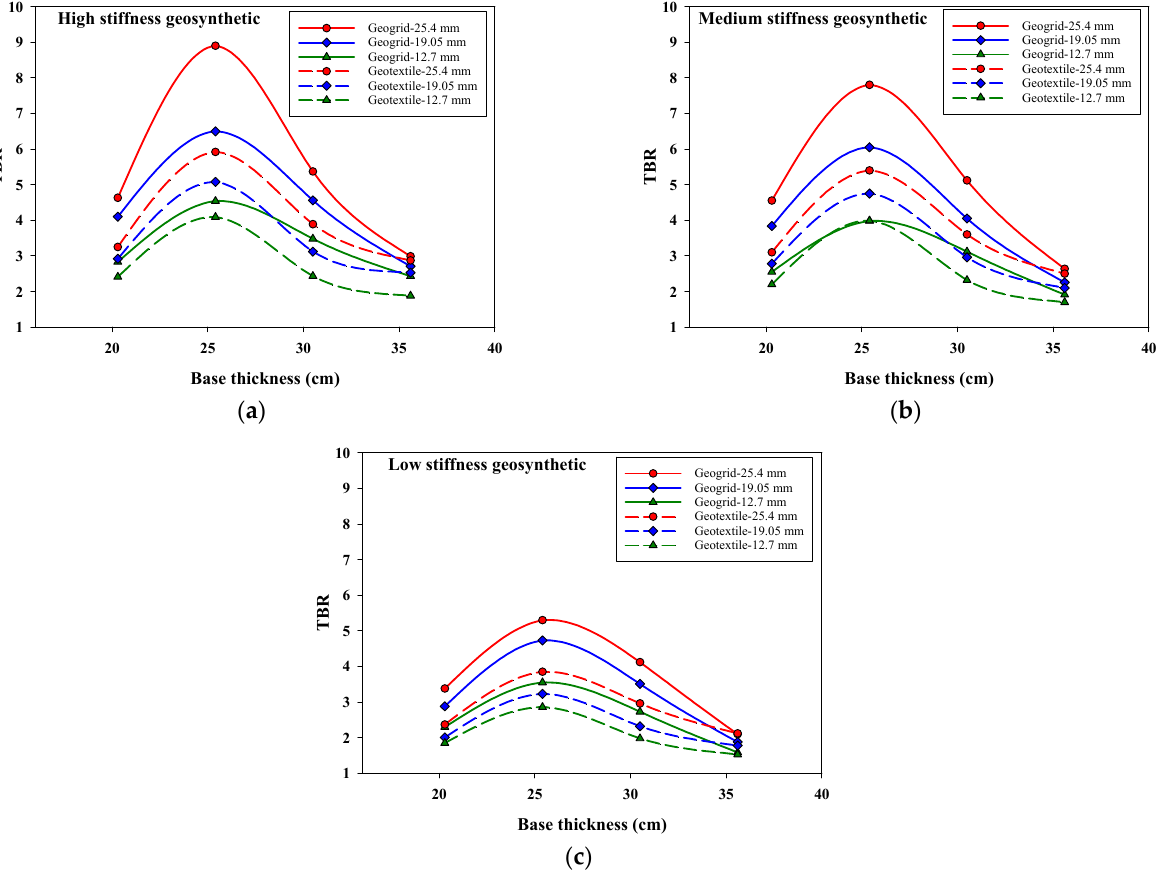
Figure 9. TBR variations with base thickness for pavements reinforced with a single layer of ( a ) high, ( b ) medium, and ( c ) low stiffness geosynthetics on the weak subgrade.